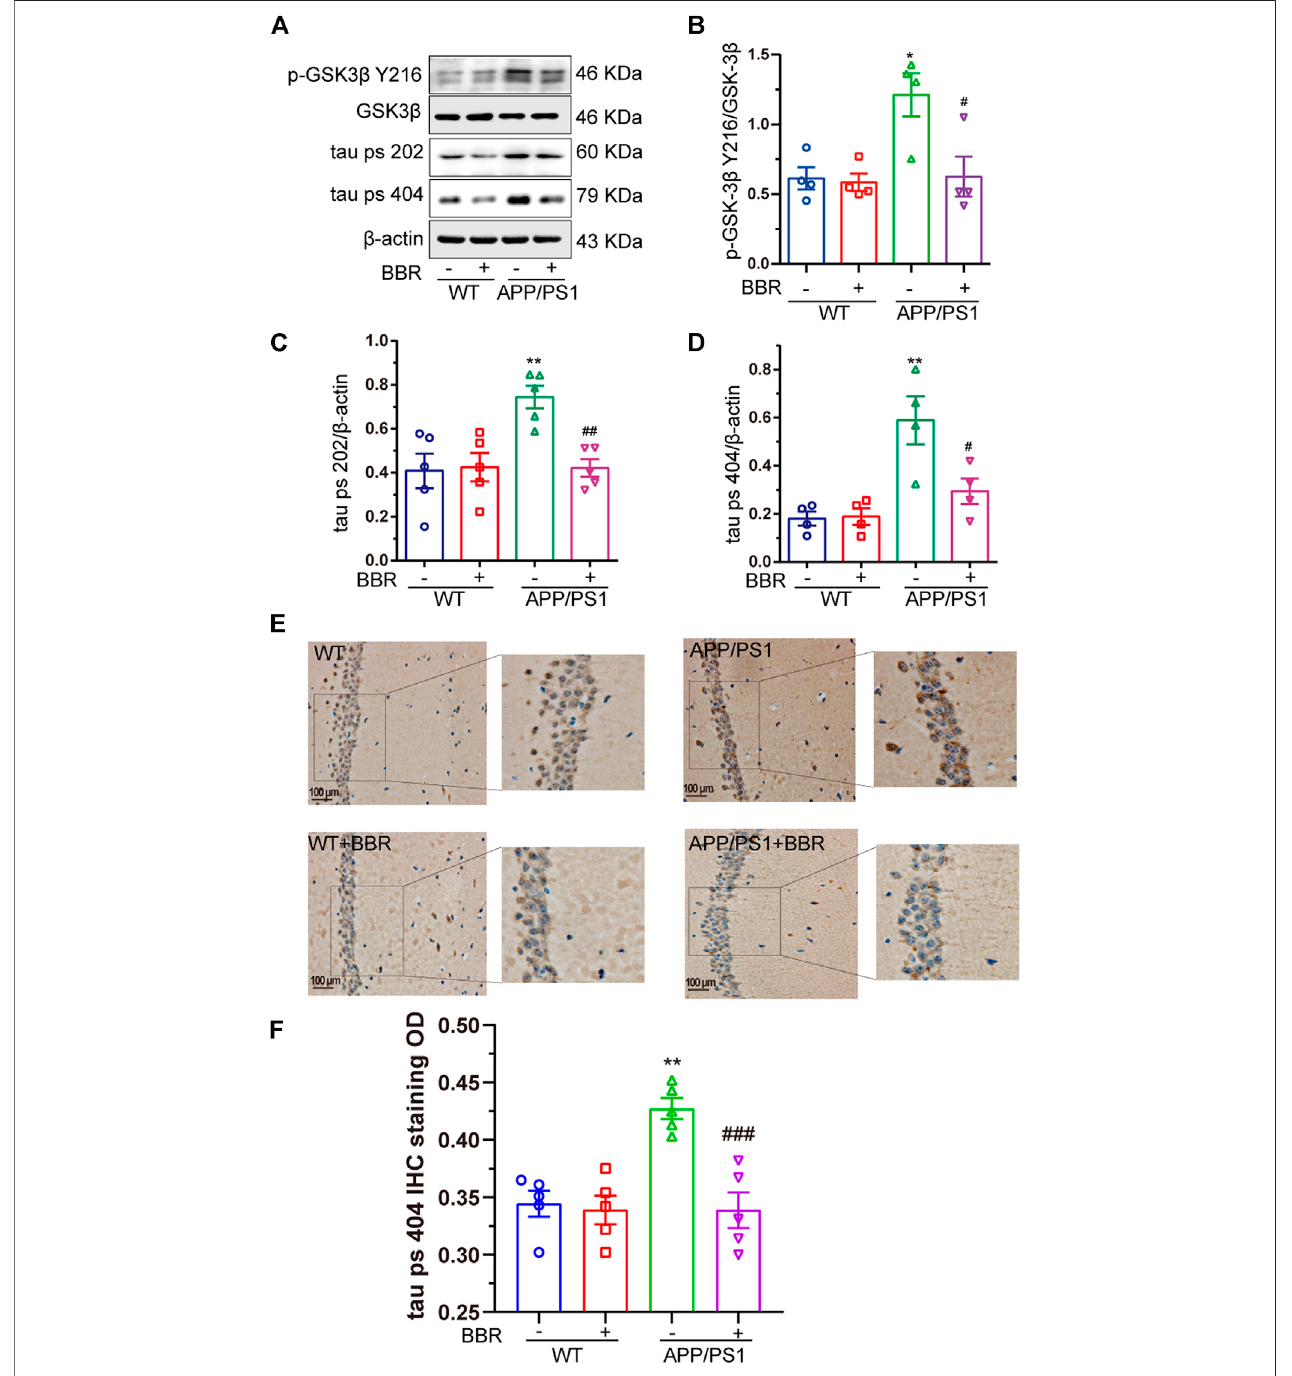
FIGURE 4 | Berberine suppresses GSK3 β activity and decreases tau hyperphosphorylation in APP/PS1 mice. (A) Western blot detection of p-GSK3 β Y216, GSK3 β , tau ps 202, and ps 404 in the hippocampal tissues of mice. (B – D) Quanti fi cation of Western blotting results of p-GSK3 β Y216, tau ps 202, and ps 404 in the hippocampaltissuesofmice. (E) RepresentativeIHCstainingimagesoftaups404intheCA1regionofmicehippocampaltissues.Scalebaris100 μ m. (F) Quanti fi cation of IHC staining. Data were presented as means ± SEM. * p < 0.05, ** p < 0.01 vs. WT; # p < 0.05, ## p < 0.01, ### p < 0.001 vs. APP/PS1 without BBR.